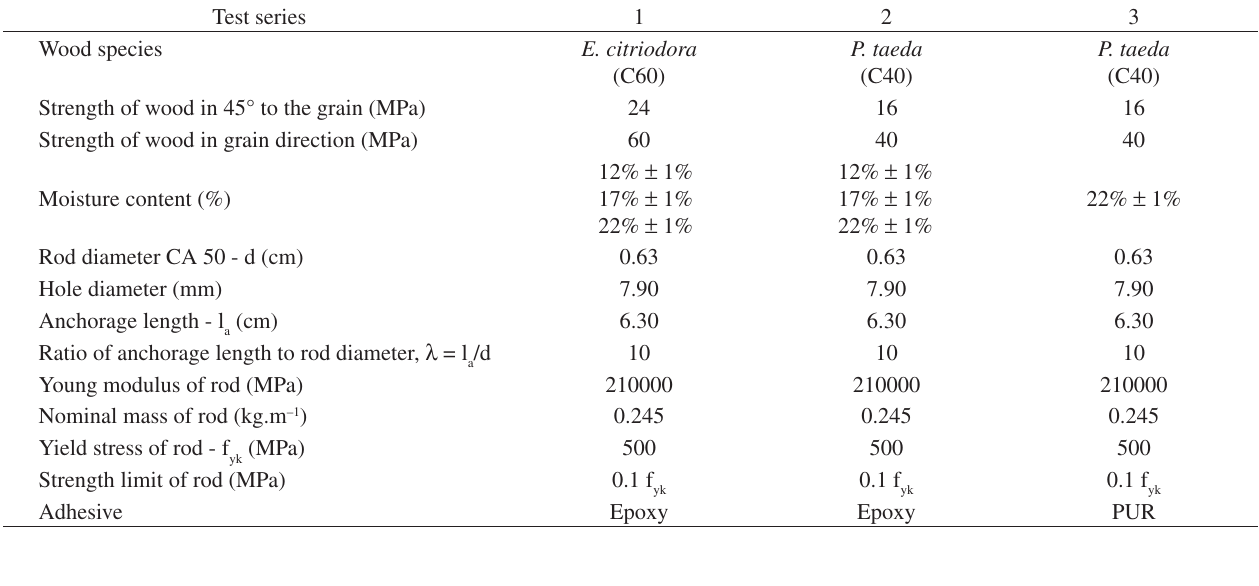
Table 1. Static and fatigue test specimens.